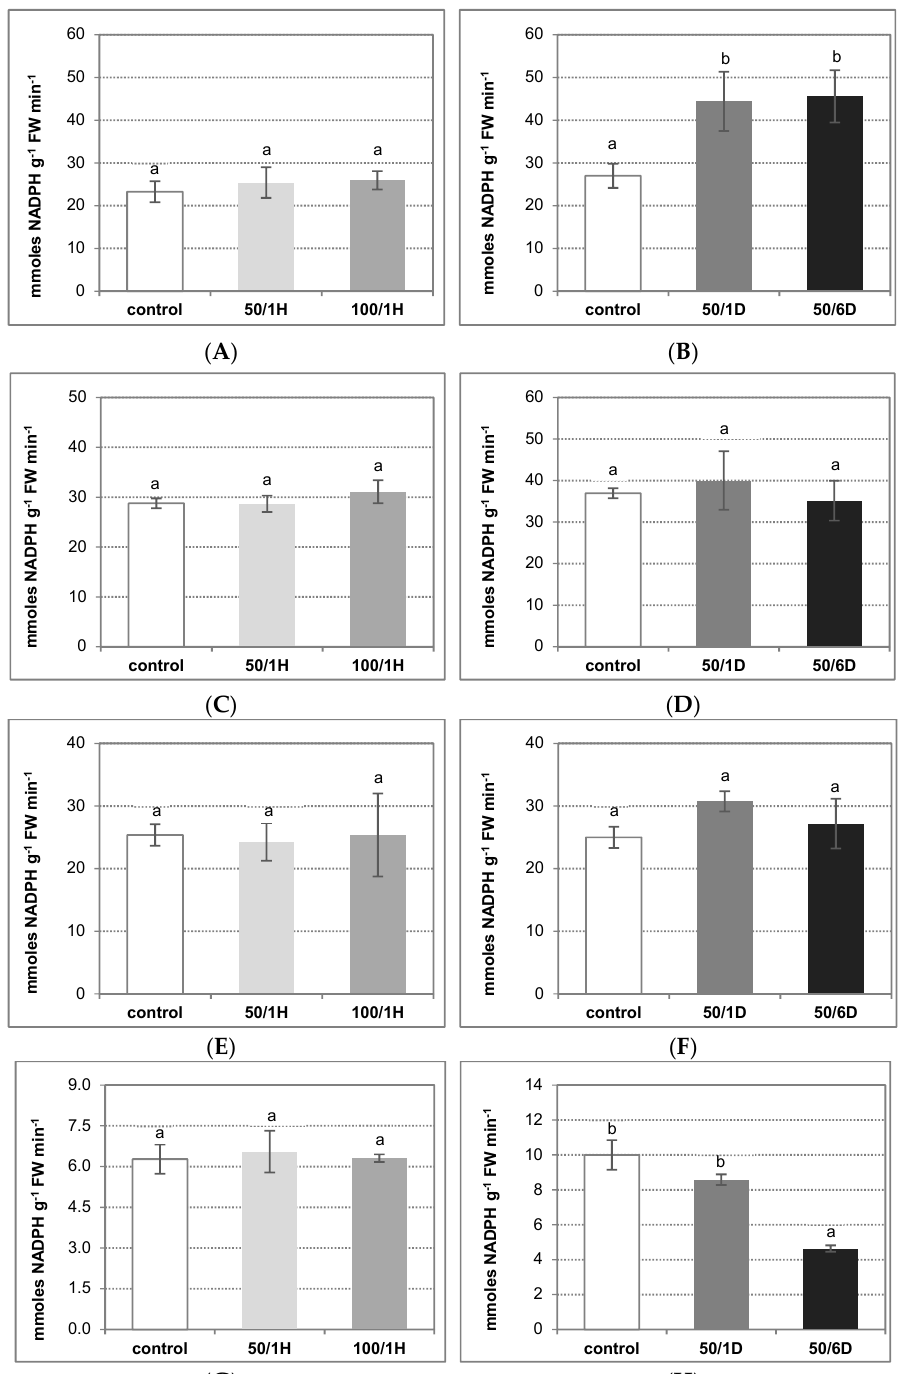
0.01.53.04.56.07.59.0 Figure 5. Activity of NADPH-generating enzymes: G6PDH ( A , B ), 6PGDH ( C , D ), NADP-ICDH ( E , F ), and NADP-ME ( G , H ) in the roots of cucumber seedlings exposed to salinity. The cucumber seedlings were treated with: ( A , C , E , G ) 50 mM or 100 mM NaCl for 1 h (50/1H and 100/1H, respectively); ( B , D , F , H ) 50 mM NaCl for 1 or 6 days (50/1D and 50/6D, respectively). The activities of NADP dehydrogenases were determined in the roots, as described in Materials and Methods. The presented results are the means ± SD of three independent experiments, each run in triplicate, and are expressed as nmoles of NADPH g − 1 FW min − 1 . Different letters show different homogeneous groups of means calculated by Duncan’s multiple range test (significant at p < 0.05).